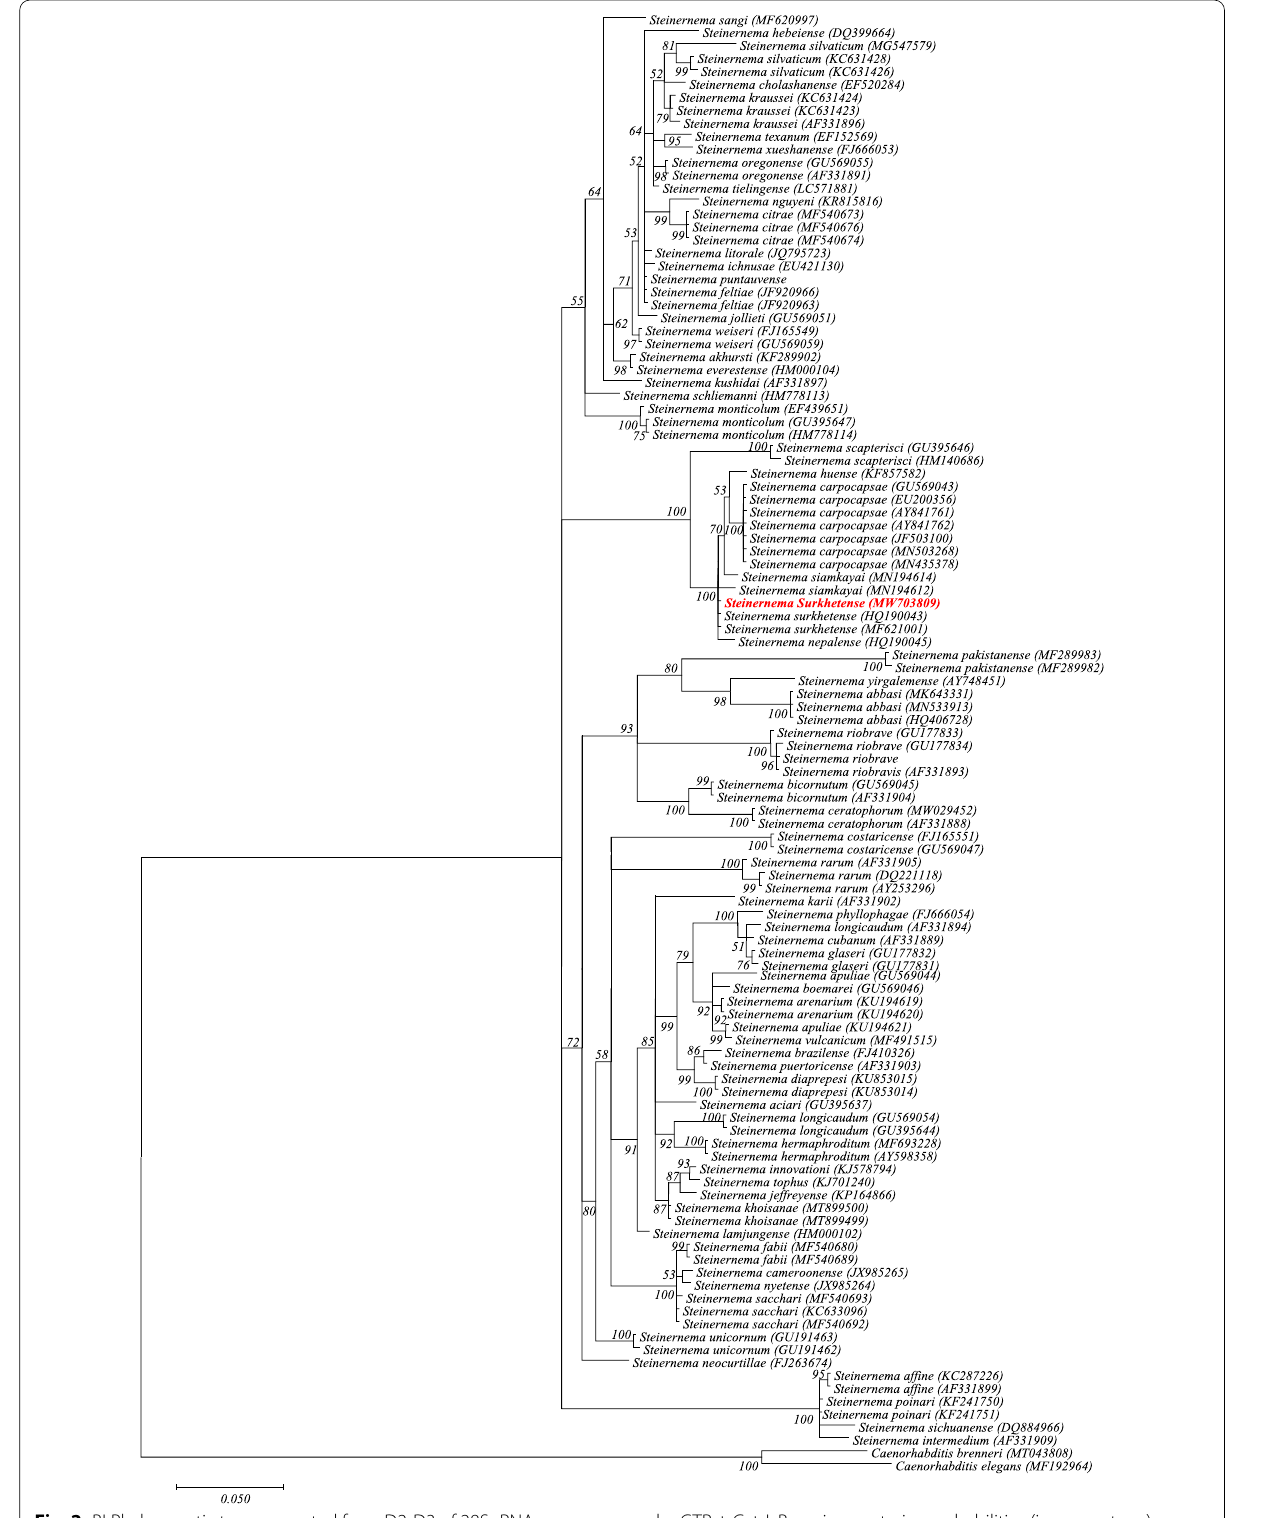
Fig. 2 BI Phylogenetic tree generated from D2-D3 of 28S rRNA sequences under GTR given next to each node. Sequence of Steinernema surkhetense from Vietnam is in red and